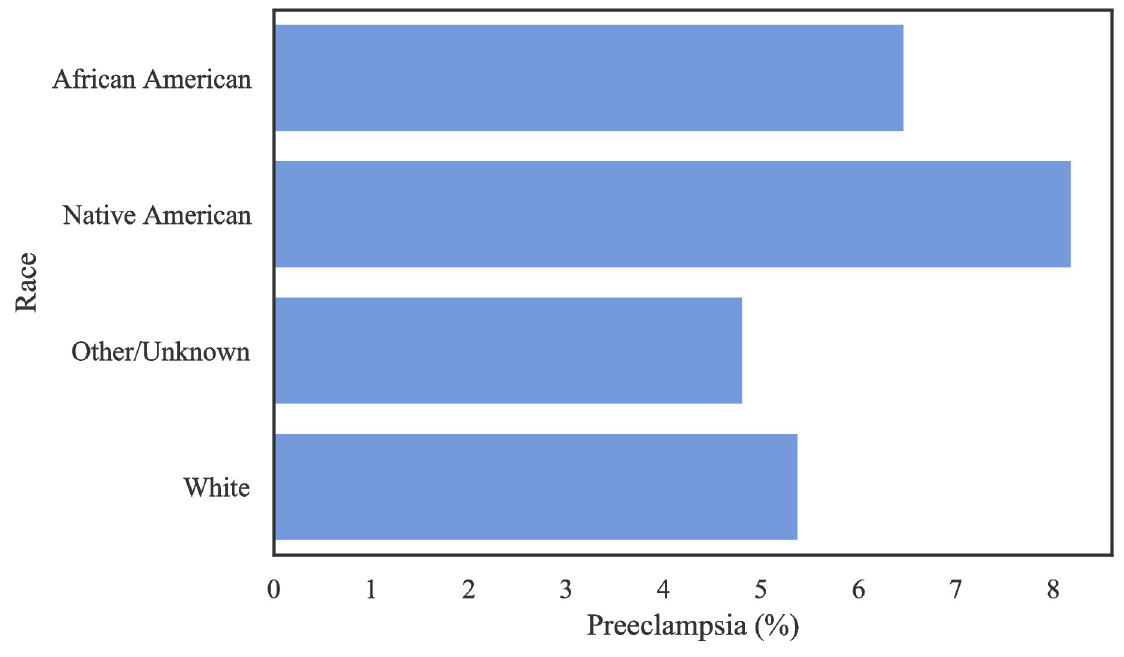
Fig 6. The rate of PE per race in the Oklahoma